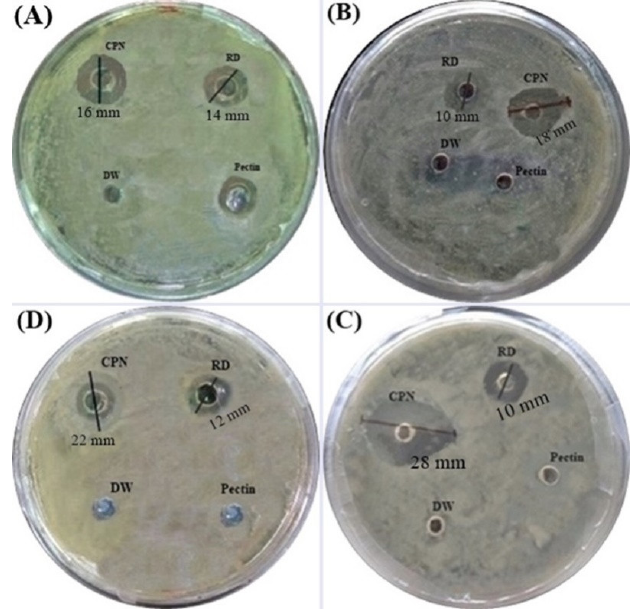
Table 5. Zone of inhibition for drug vs nanoparticles 288 Bacterial strain Figure 12. Zone of inhibition of CPN, and RD against Bacillus cereus ( a ), Bacillus polymyxa ( b ), Enterobacter aerogenes ( c ), and pseudomonas aeruginosa ( d